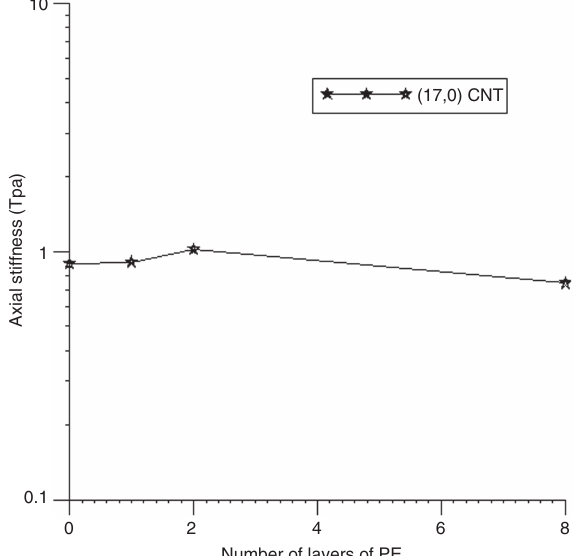
Figure 6 Variation of elastic stiffness of core single-walled nanotube with the number of layers of polyethylene matrix.